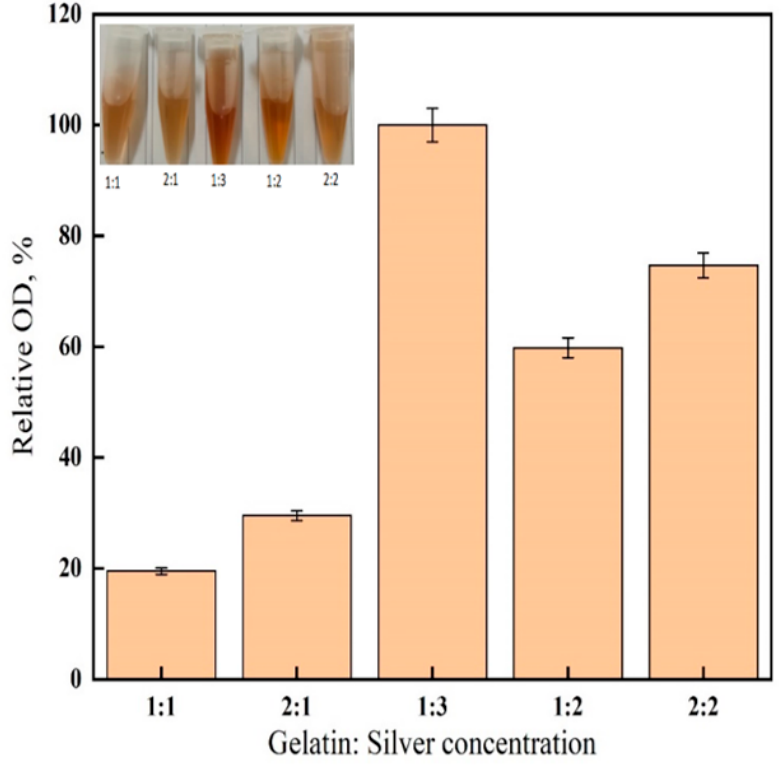
Figure 1. Effect of gelatin- silver reagent ratio on the color evolution. Conditions: A 1 mL of the reaction mixture contained 250 µ L maltose (0.1 mM), 250 µ L Tris–HNO 3 buffer PH 8.5 (0.2 M), 500 µ L gelatin-silver reagent (1:1, 2:1, 1:3, 1:2, and 2:2), incubated for 10 min at 90 ◦ C, cooling read absorbance at 434 nm. Each point represents the mean of three experiments ± SE.